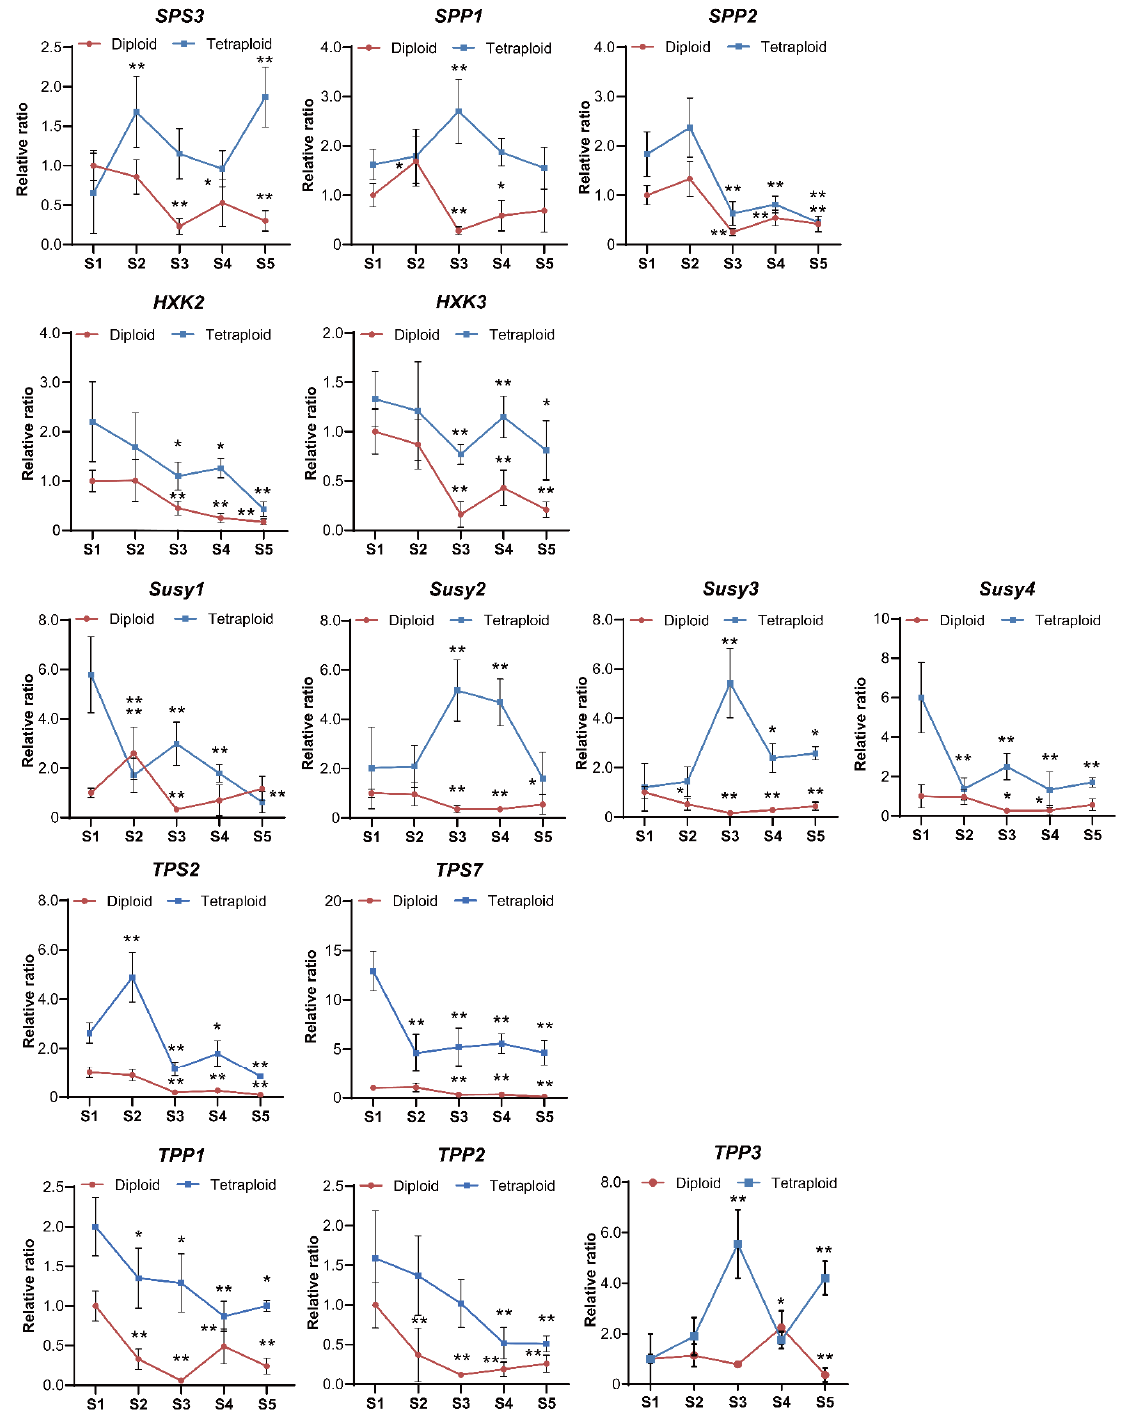
Figure 7. Expression patterns of sucrose-metabolism-related genes in allodiploid and allotetraploid lilies during development and flowering. S1–S5 represent the five developmental stages. The normalized expression levels in the allodiploids at S1 were arbitrarily set to 1. The data are the means ± SDs of three biological replicates, with three technical replicates. Significant differences between all the samples and plantlets of allodiploids and allotetraploids at S1 were determined by Student’s t -test (*, p < 0.05, **, p <